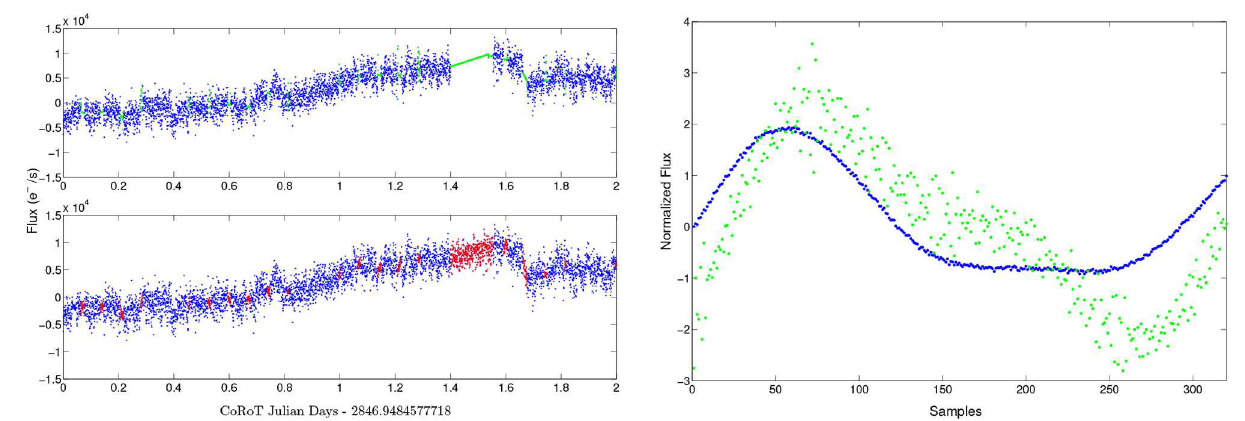
FIGURE 1 | (Left) A short segment of the CoRoT lightcurve of HD49933, the first solar-like star observed by CoRoT. The figure shows a gap filled using linear (upper panel in green) and MIARMA (lower panel in red) interpolation, respectively. (Right) A short segment of the CoRoT lightcurve of HD181555 (blue points) showing the connectivities of the data points (green points). Notice the correlation with the original time